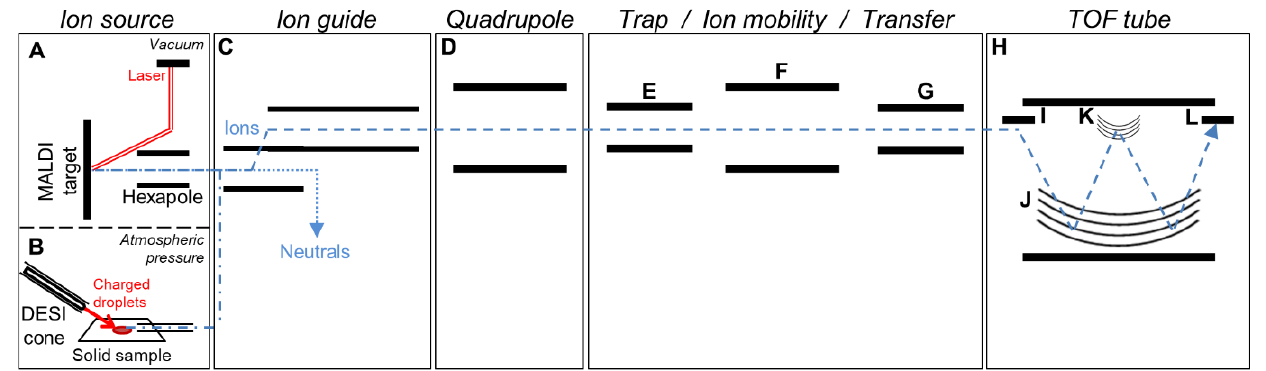
Figure 1. Schematic representation of the Waters Synapt G2-Si device. Matrix-assisted laser desorption/ionization (MALDI) source with laser, MALDI target and hexapole ion guide ( A ) and desorption electrospray ionization (DESI) source with DESI sprayer, solid sample, and transfer line ( B ). Off-axis ion guide ( C ), quadrupole for ion selection ( D ). Trap cell for collision-induced dissociation (CID) or ion selection ( E ), travelling wave ion mobility cell ( F ), transfer cell for CID or ion selection ( G ). Time of flight (TOF) tube ( H ) consisting of a high field pusher ( I ), a dual stage reflectron ( J ), an ion mirror for resolution (W) mode ( K ), and an ion detection system ( L ). The laser beam and charged droplet spray responsible for the ionization processes are shown in red solid lines, and the paths of neutrals and ions are shown in blue dotted